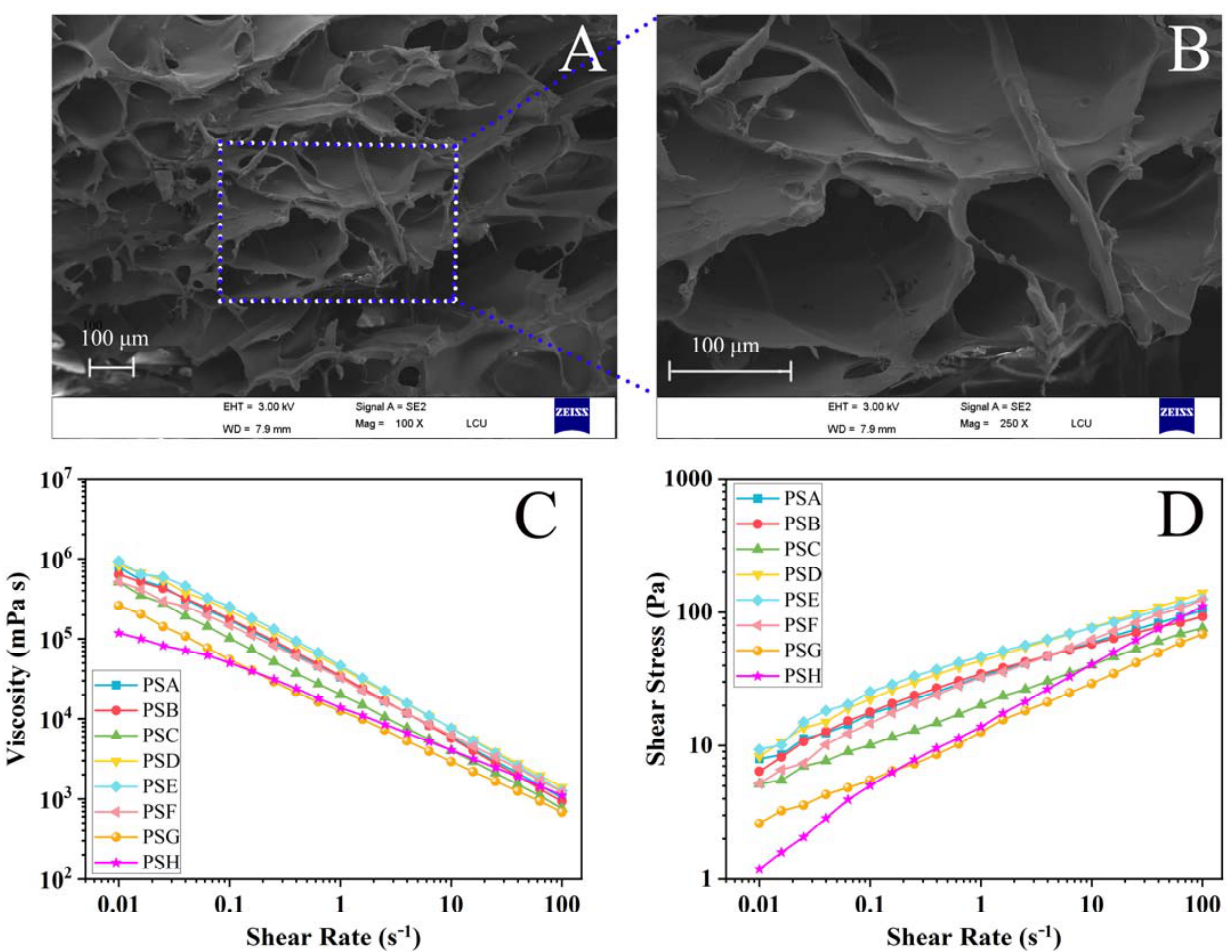
Figure 1. The SEM image of lyophilized PSA (The area within the dotted frame is the area for further magnification scanning) ( A ) and partial enlarged image ( B ); the viscosity ( C ) and shear Stress ( D ) curves in the pectin-salecan gels’ steady flow tests.